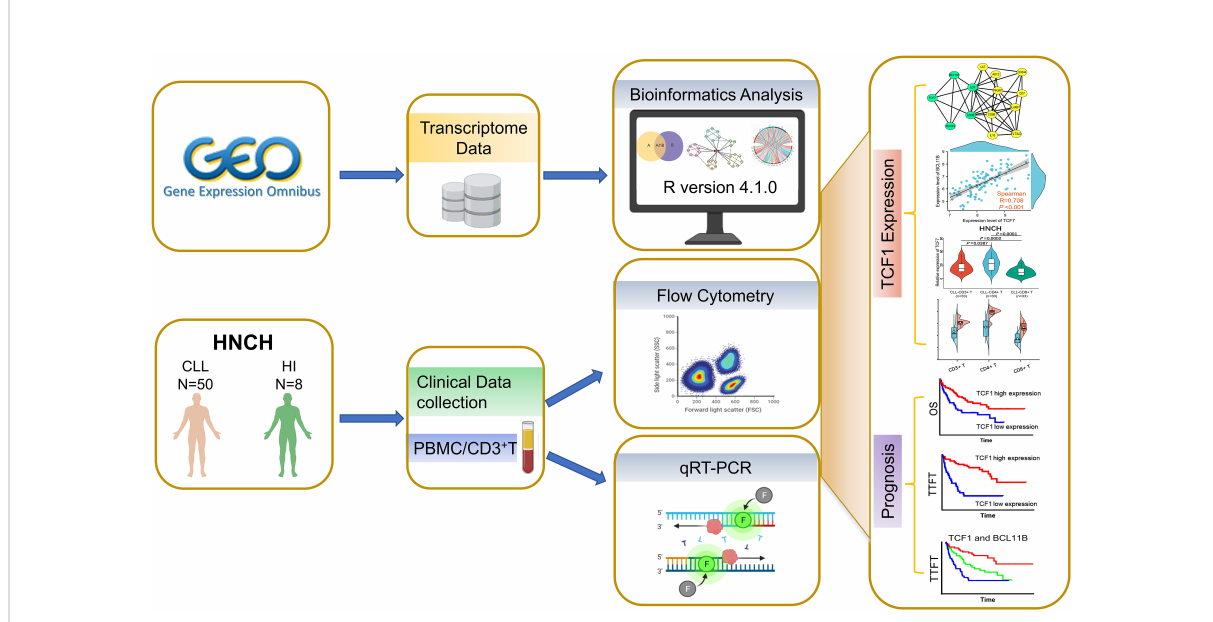
FIGURE 1 Study fl ow chart. The expression, biological function, and effects of TCF1 and its co-expressing genes were analyzed in the GEO and STRING databases. Then, the above fi ndings were validated in 50 CLL patients from Henan Cancer Hospital